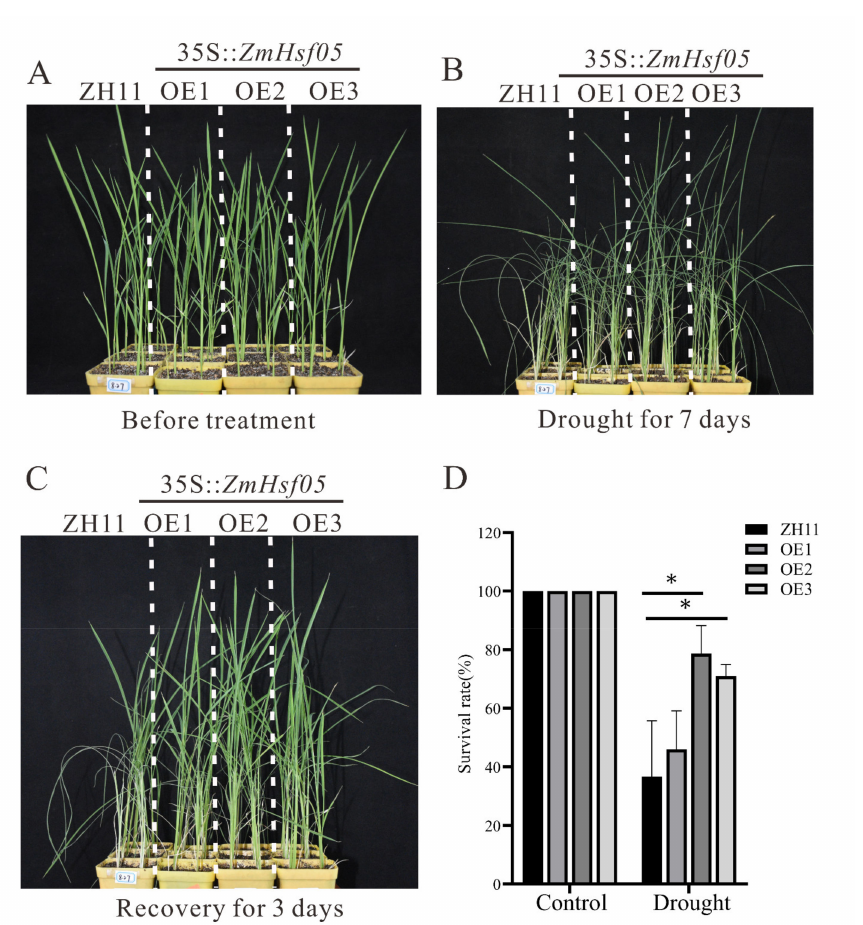
Figure 6. Drought tolerance analysis of rice with ZmHsf05 overexpression in soil. Three transgenic rice ZmHsf05 overexpression lines (OE1, OE2, and OE3) and wild-type ZH11 were cultured in soil. Rice were grown for three weeks at normal conditions ( A ), the watering was stopped and the drought treatment was carried out for 7 days ( B ). After the appearance of the phenotype, we re-cultivated the rice seedlings by watering them for 3 days ( C ). ( D ) Statistics of the survival rate of overexpression lines and WT after drought treatment. Vertical bars indicate means ± SEs ( n = 3). *, p < 0.05 (Student’s t